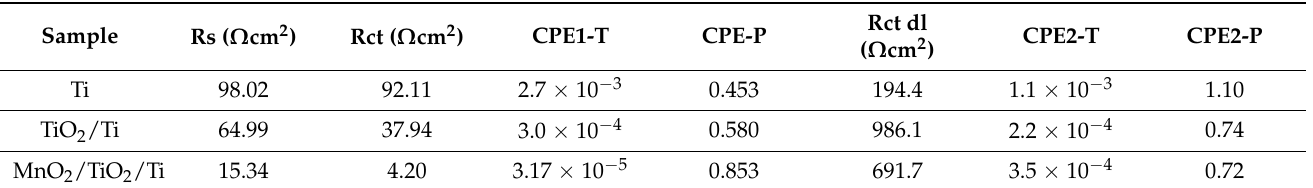
Figure 5. ( a ) Nyquist diagram and ( b ) Bode plots of metal porous Ti, surface-modified TiO 2 /Ti and MnO 2 /TiO 2 /Ti nanocomposites and equivalent circuits. Table 2. Results of the EIS fitting texts of the porous Ti, surface-modified TiO 2 /Ti, and MnO 2 /TiO 2 /Ti nano